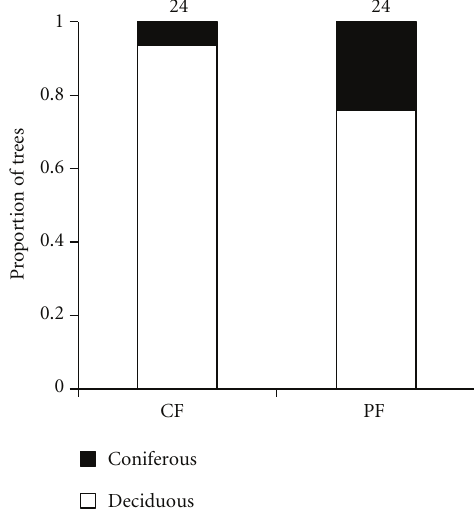
Figure 4: Proportion of coniferous versus deciduous tree species in the breeding territories of collared flycatchers (CF) and pied flycatchers (PF) subject to experimental cross- fostering of their nestlings on ¨Oland, Sweden, 2002–2009. The territories of collared flycatchers had a relatively higher proportion of deciduous trees as compared to the territories of pied flycatchers. Sample sizes are given above the bars.